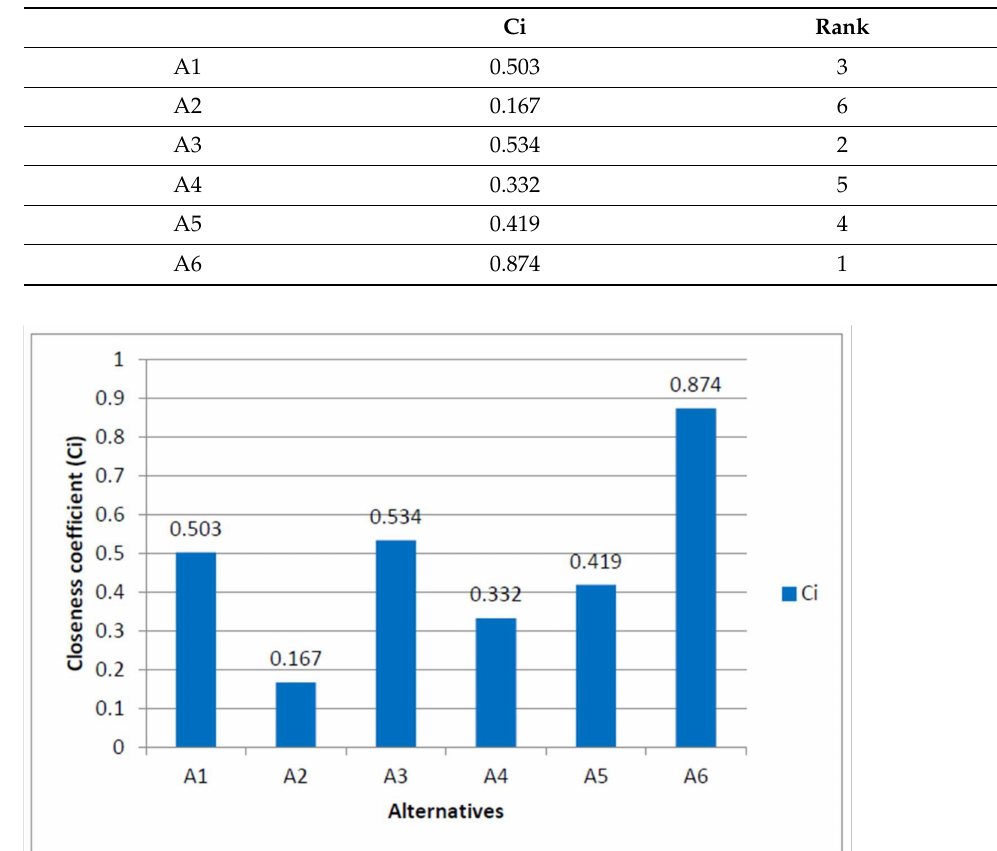
Table 9. Closeness coefficient.